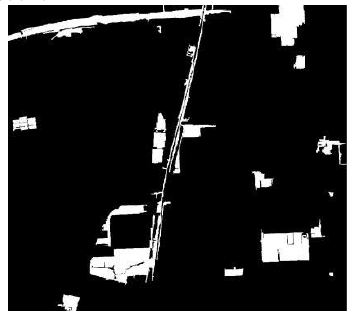
Figure 7. Reference of Change